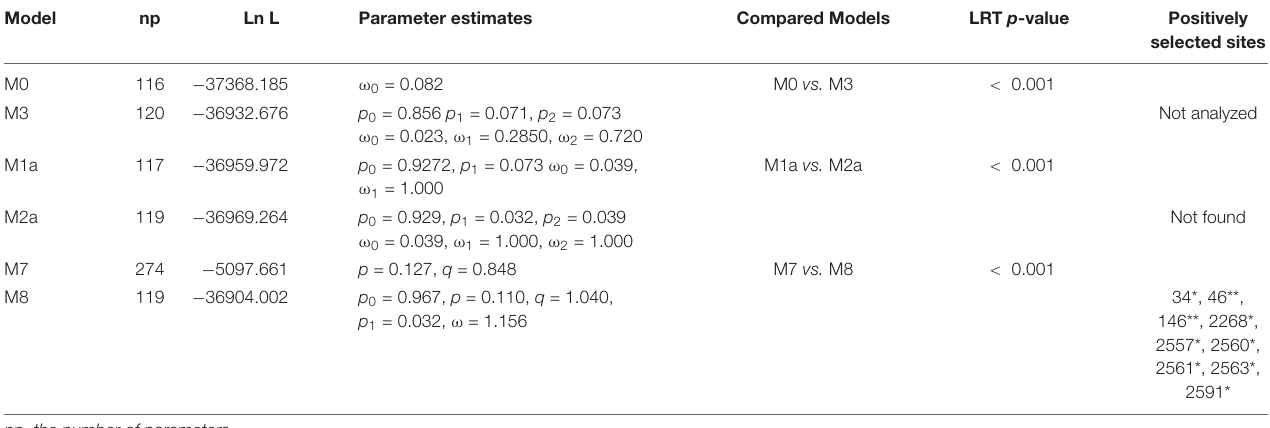
TABLE 5 | Site model tests on the complete genome of PVA. Model